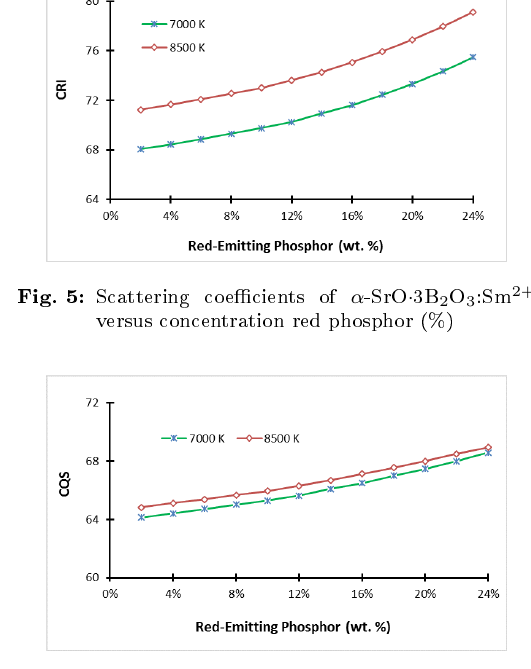
Fig. 6: CRI properties of WLEDs with various α - SrO · 3B 2 O 3 :Sm 2+ concentrations.